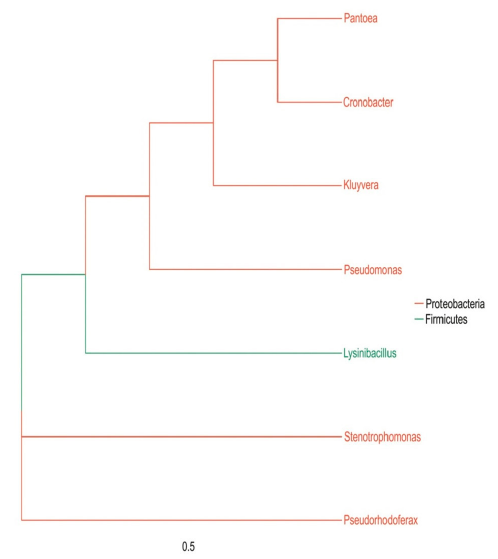
Fig 2. Phylogenetic tree of different genera